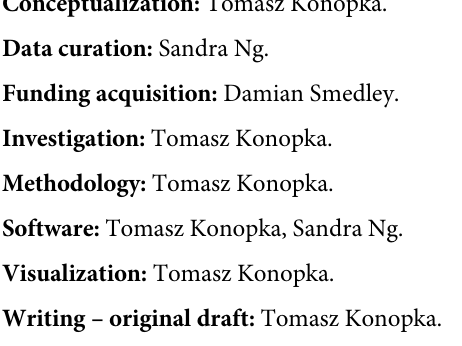
S1 Table. Complete set of HP-MP translations and evaluation metrics. Columns ‘id’ and ‘name’ refer to queries from the HP ontology. Columns ‘expected’ and ‘expected_name’ denote MP terms produced by an ontology-aware translation algorithm, owlsim. Columns ‘target’ and ‘target_name’ refer to translations produced by the search algorithm. Column ‘target_N’ lists the top 5 search results. Column ‘method’ indicates the level of data diffusion: ‘plain’ for search without diffusion, ‘diffused’ for diffusion using co-occurrence within the HP ontology, and ‘best’ for the best diffusion configuration using both MP and a manual dataset. Columns ‘precision’ and ‘pathlen’ quantify the presence of a match and the extent of disagreement between expected and target results. Columns ‘precision_bestN’ and ‘pathlen_bestN’ are anal- ogous fields, but using the best results out of the top 5 search